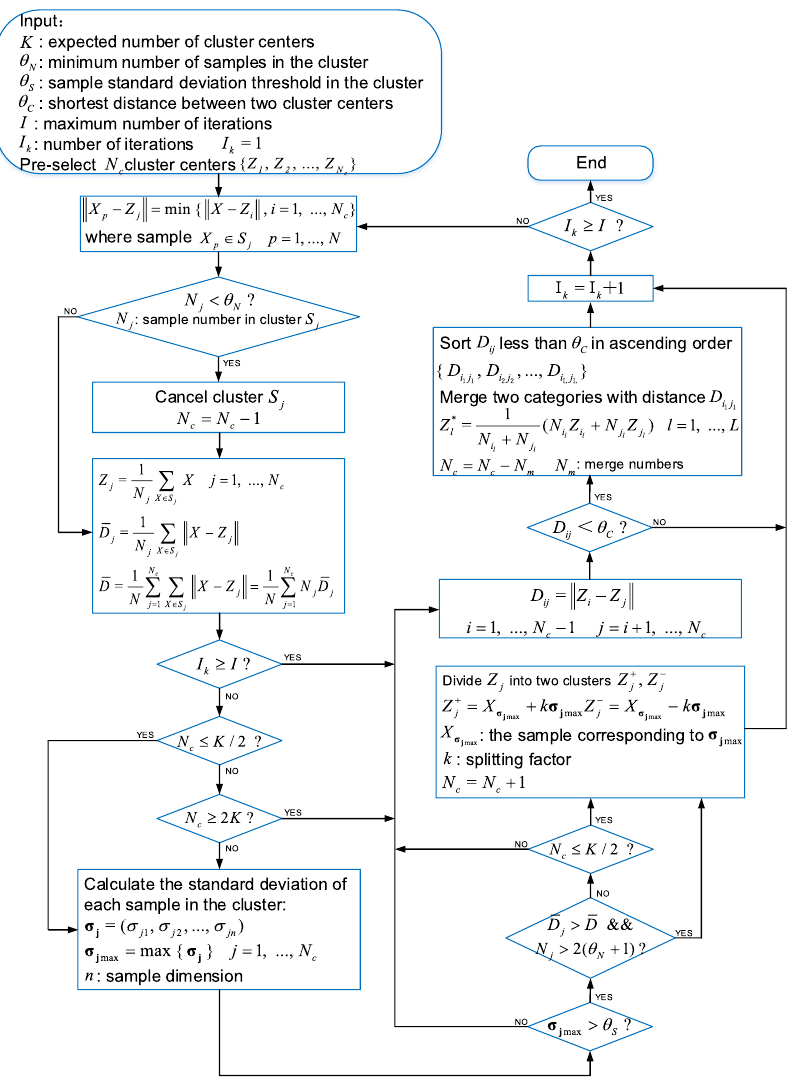
Figure 7. Flow diagram of ISODATA